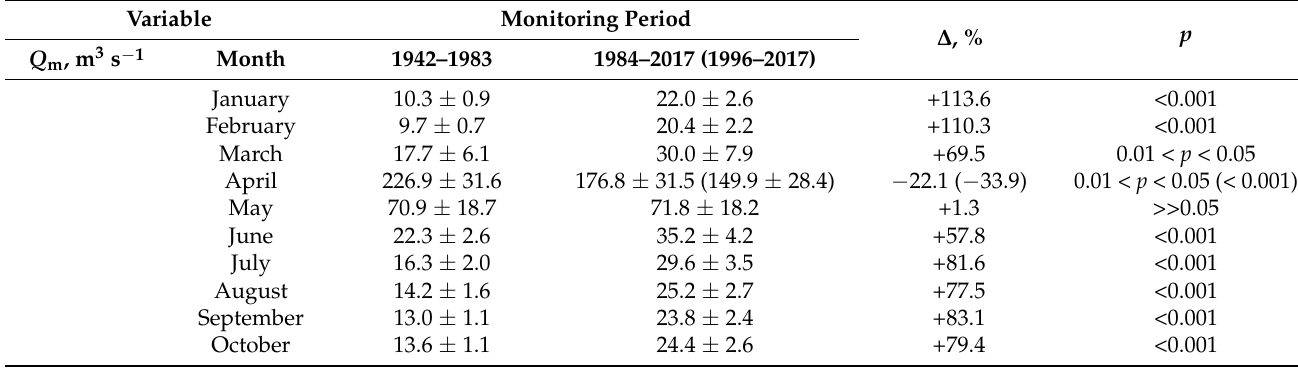
Table 5. Changes in water discharge of the Bolshoy Kinel’ River at Timashevo, the eastern part of the Samara Oblast and the western part of the Orenburg Oblast of European Russia (see Figure 2A,B), during 1942–2017.